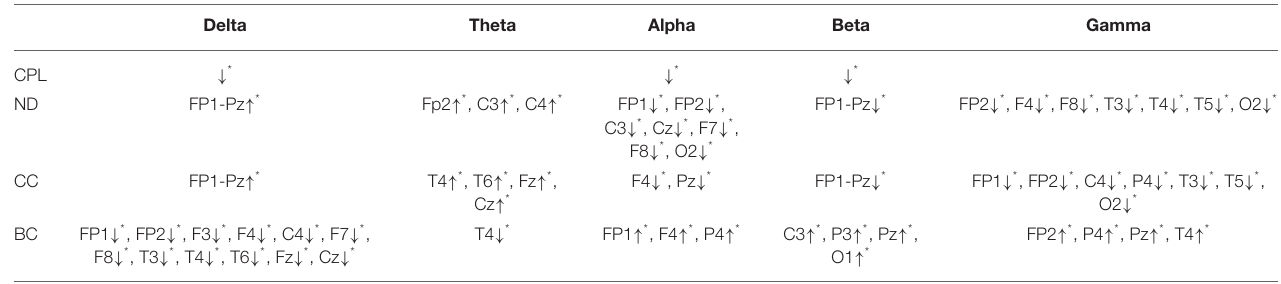
TABLE 2 | Characteristics of brain networks in different frequency bands of IS compared WS with WNS stage. Delta Theta Alpha Beta